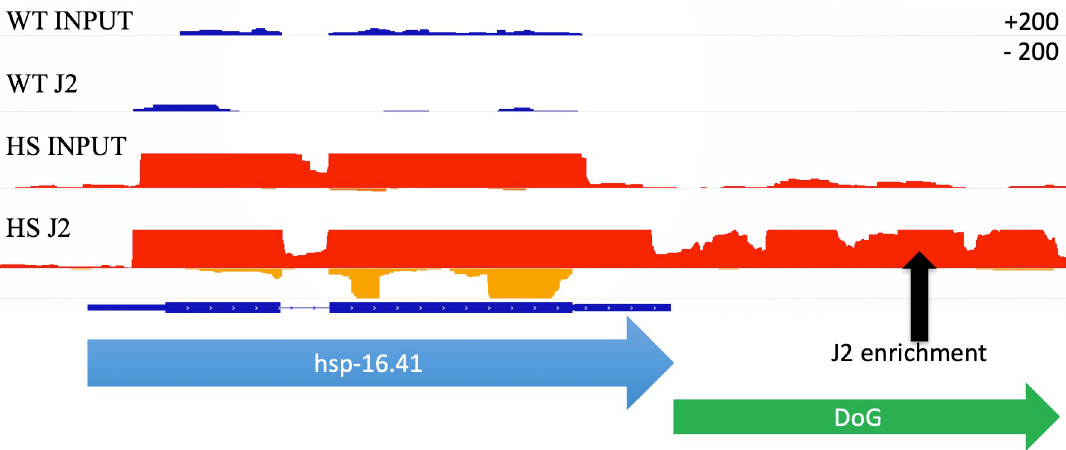
Fig 4. Aberrant transcription past the end of heat shock family genes showed enrichment in heat shock J2. Normalized histogram from the Integrative Genomics Viewer (IGV). On each track, the sense strand is on the top part of the histogram and antisense is on the bottom (Max read depth +/- 200). Wild type (WT) sense (dark blue) and antisense (light blue), heat shock (HS) sense (red) and antisense (orange). Gene transcription continues past the 3’ end of gene (blue arrow) in heat shock, leading to an annotated downstream of gene transcript (DoG) (green